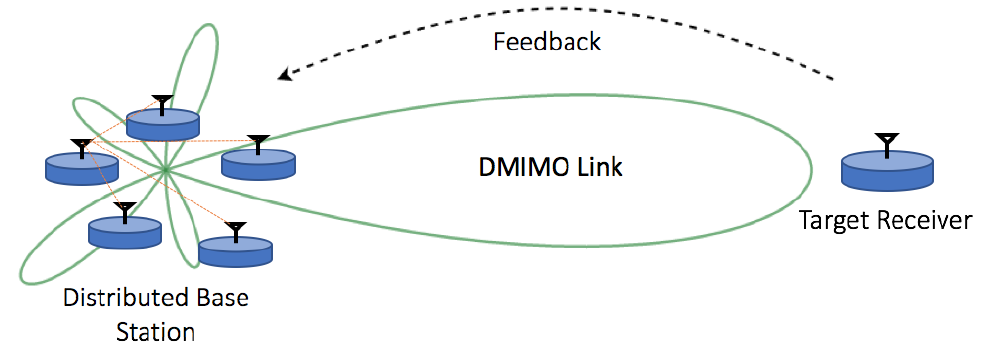
Figure 1. The distributed base station concept